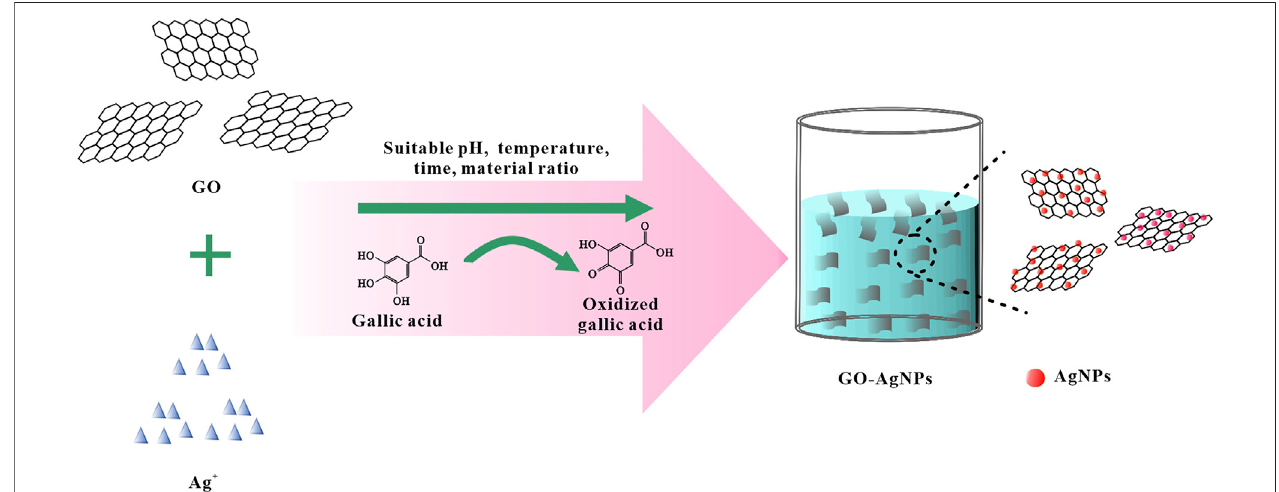
FIGURE 1 | Schematic diagram of the synthesis of